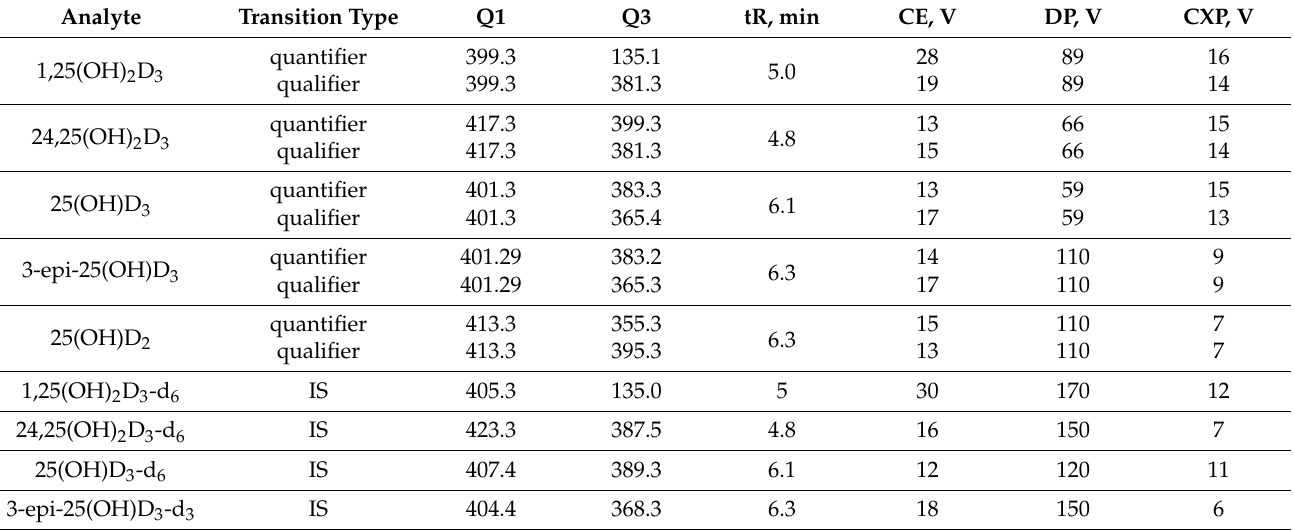
Table A2. Multiple reaction monitoring transitions used for the detection of vitamin D